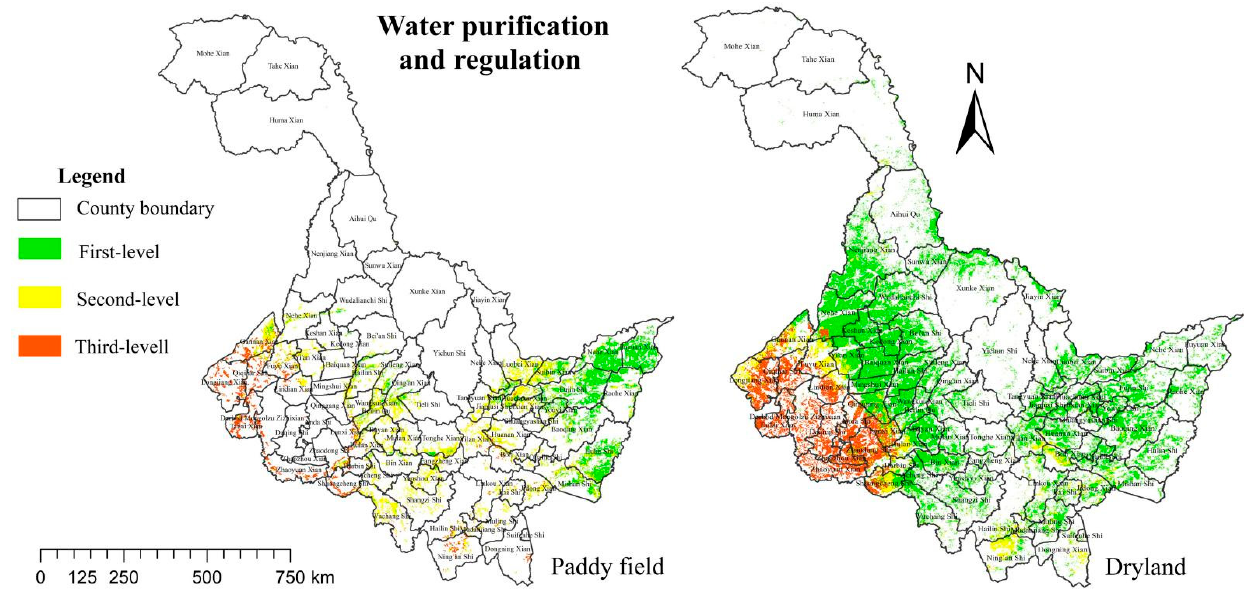
Figure 8. The grade of soil water purification and regulation function in paddy fields and drylands.